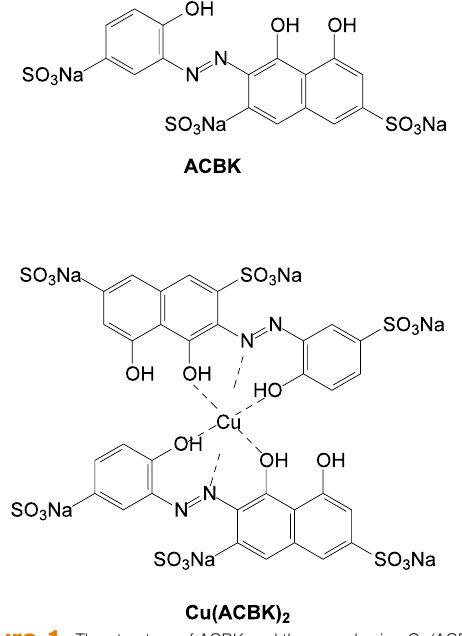
Figure 1. The structure of ACBK and the complex ion Cu(ACBK) 22+